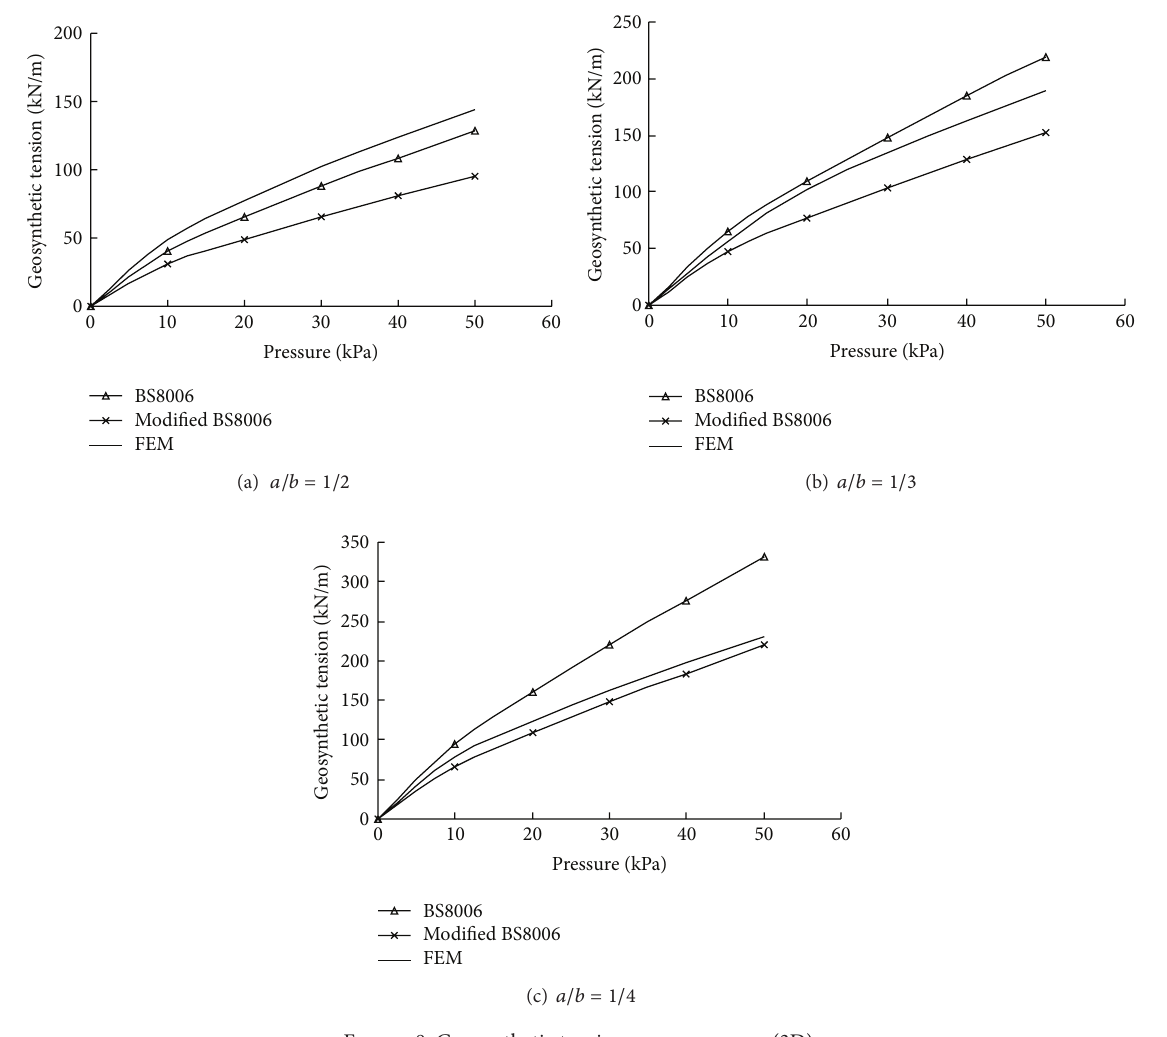
Figure 8: Geosynthetic tension versus pressure (3D).